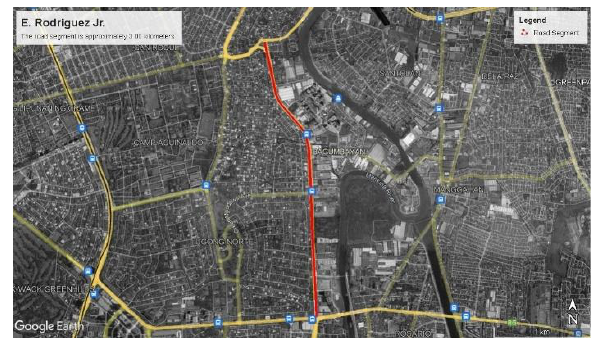
Figure 3. E. Map of Rodriguez Jr.